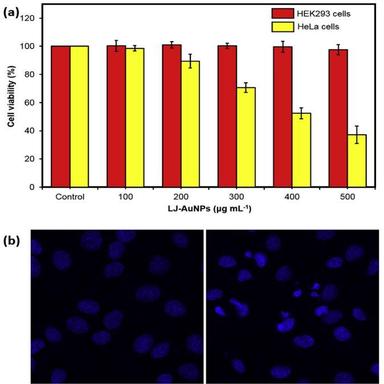
(a) Cell viability of AuNPs synthesized using Lonicera japonica flower extract on HEK293 (embryonic kidney cells) and HeLa (cervix cancer) cells, and (b) Fluorescence microscopic images of HeLa cells obtained by DAPI staining.